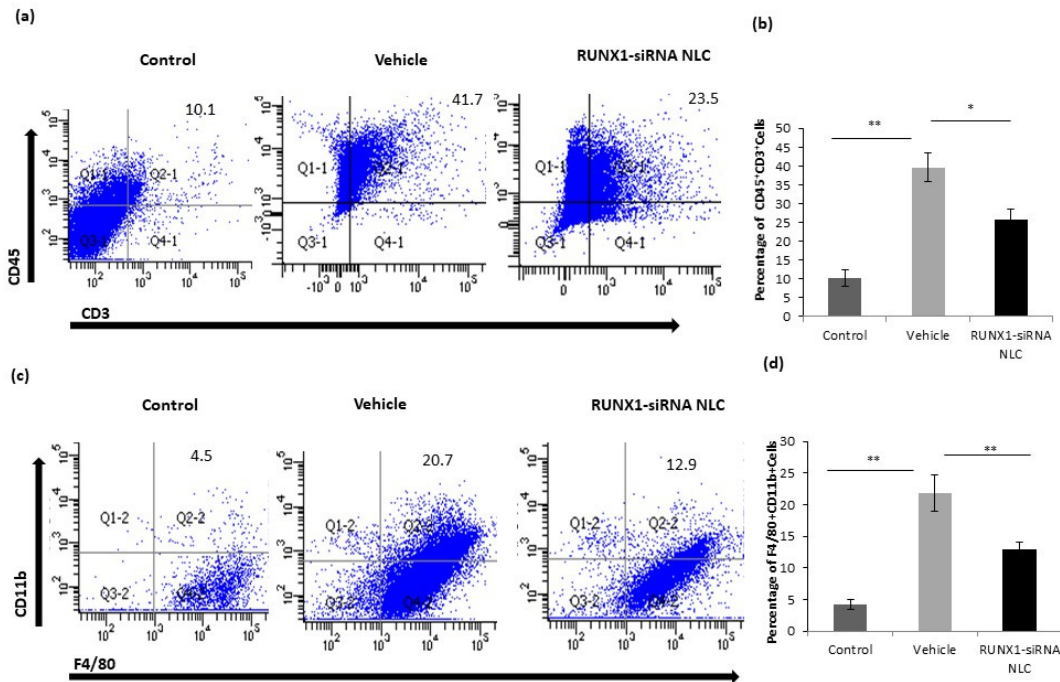
Figure 6. Immune modulation in RUNX siRNA NLC-treated mice. ( a , b ) Representative dot plots and bar diagrams showing percentages of CD45 + CD3 + leukocytes in liver-infiltrating lymphocytes in control, vehicle, and RUNX1 siRNA NLC mice. ( c , d ) Representative dot plots and bar diagrams percentages of CD11b + F4/80 + leukocytes in liver-infiltrating lymphocytes in control, vehicle, and RUNX1 siRNA NLC mice. Data represented as mean ± SD, n = 5 * p < 0.05, ** p <